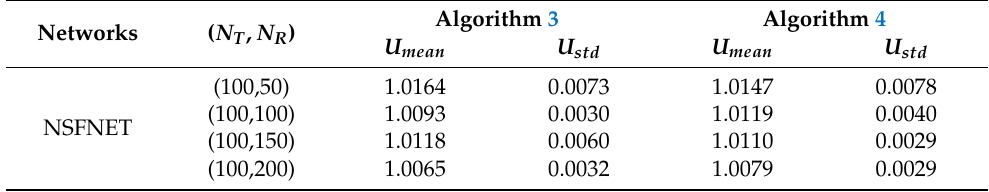
Table 2. Comparison of